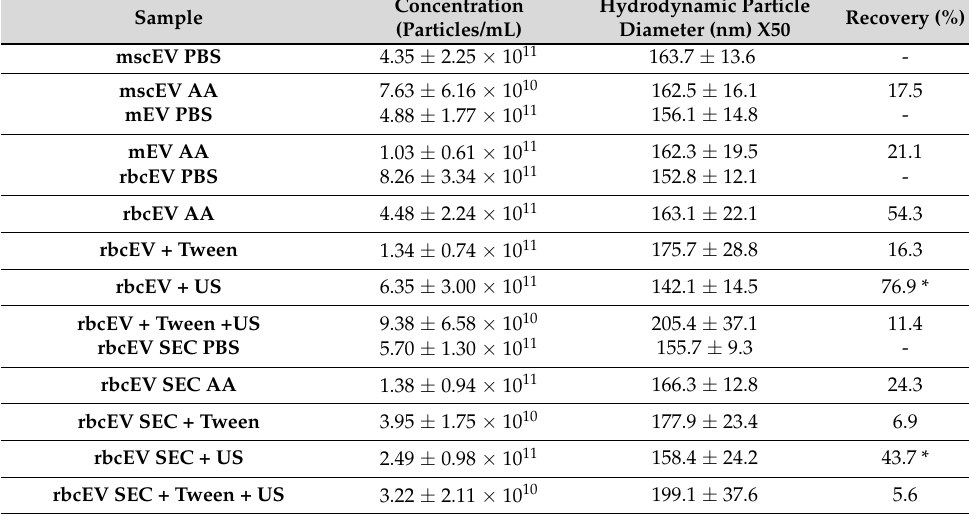
Table 2. Comparison of EVs derived from different cell types (mEV, mscEV, and rbcEV) and investi- gation of the impact of solvent exchange from PBS to ammonium acetate (AA), as well as Tween20 and ultrasonic (US) treatment on the particle concentration and the hydrodynamic particle diameter (NTA-derived; n ≥ 7). The recovery is based on the particle concentration of the original sample in PBS compared to the particle concentration of the treated sample. Concentration (Particles/mL)